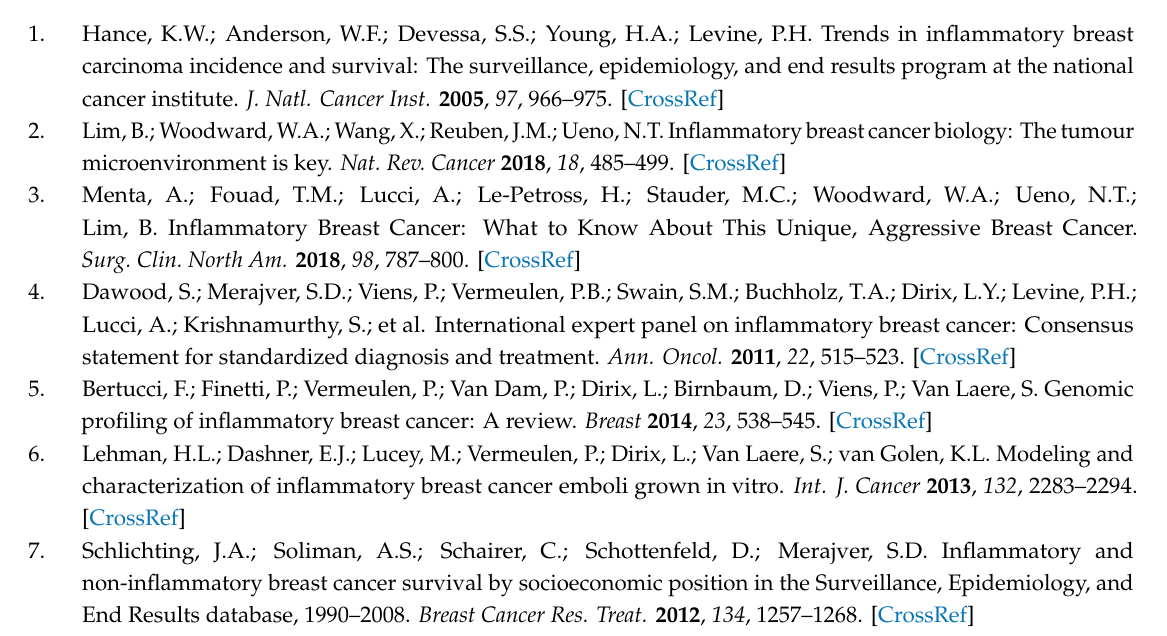
Figure S1: (A) Pipeline for variant selection and classification. (B) Complete basic and annotation pipelines for targeted next-generation sequencing (tNGS) analysis, Table S1: Complete description of all copy number alterations and cnLOH identified in 24 inflammatory breast carcinomas enrolled in this study, Table S2: Genomic gains and losses identified in at least 12 inflammatory breast carcinomas, and cnLOH detected in at least six tumor samples, Table S3: Top 10 non-redundant biological process terms identified in genes covered by the most common regions involved in copy number alterations, Table S4: Gains frequently detected in TNBC ( n = 7) compared to hormone receptor + and / or HER2 + IBC cases ( n = 17), Table S5: Genomic gains frequently identified in metastatic ( n = 17) compared to non-metastatic cases ( n = 7), Table S6: Chromothripsis-like pattern identified in nine of 24 inflammatory breast cancer cases, Table S7: Genomic instability index and homologous recombination deficiency score values for each tumor sample evaluated in this study, Table S8: Spearman correlation test for the HRD-associated scores and GII, Table S9: List of 105 genes evaluated by targeted next-generation sequencing (tNGS) in inflammatory breast carcinomas, Table S10: List of variants identified in 21 inflammatory breast carcinomas analyzed by targeted next-generation sequencing (tNGS), Table S11: Association analyses of specific mutations with high scores of HRD measures and GII, Table S12: List of genes a ff ected by variants and percentage of altered cases comparing our internal dataset (21 IBC) with non-IBC cases from TCGA, and IBC patients from four di ff erent